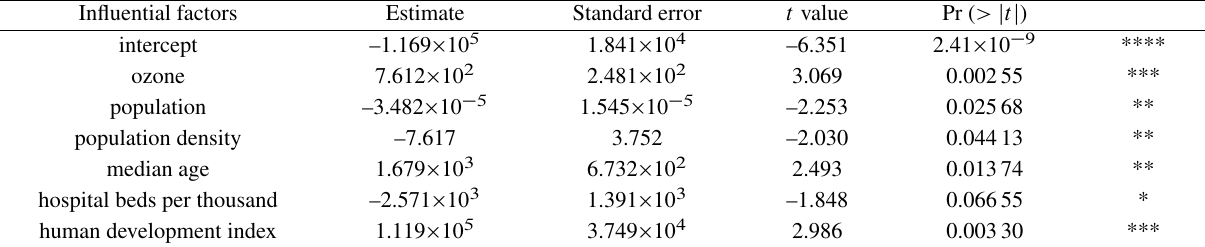
Table 3A Multiple linear regression model with TCPM as the dependent variable.